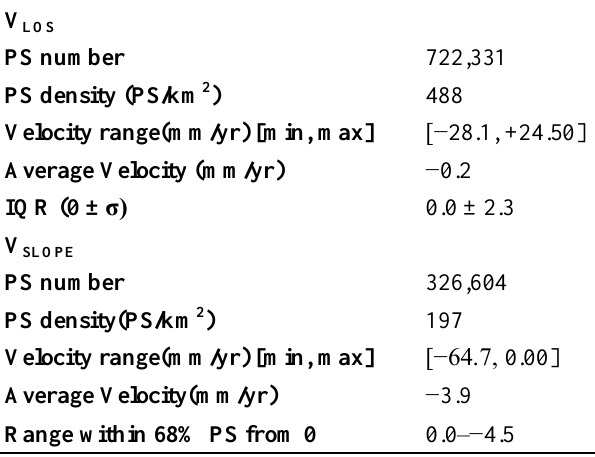
Table 2. Amounts and velocity rates of Persistent Scatterer (PS) ALOS